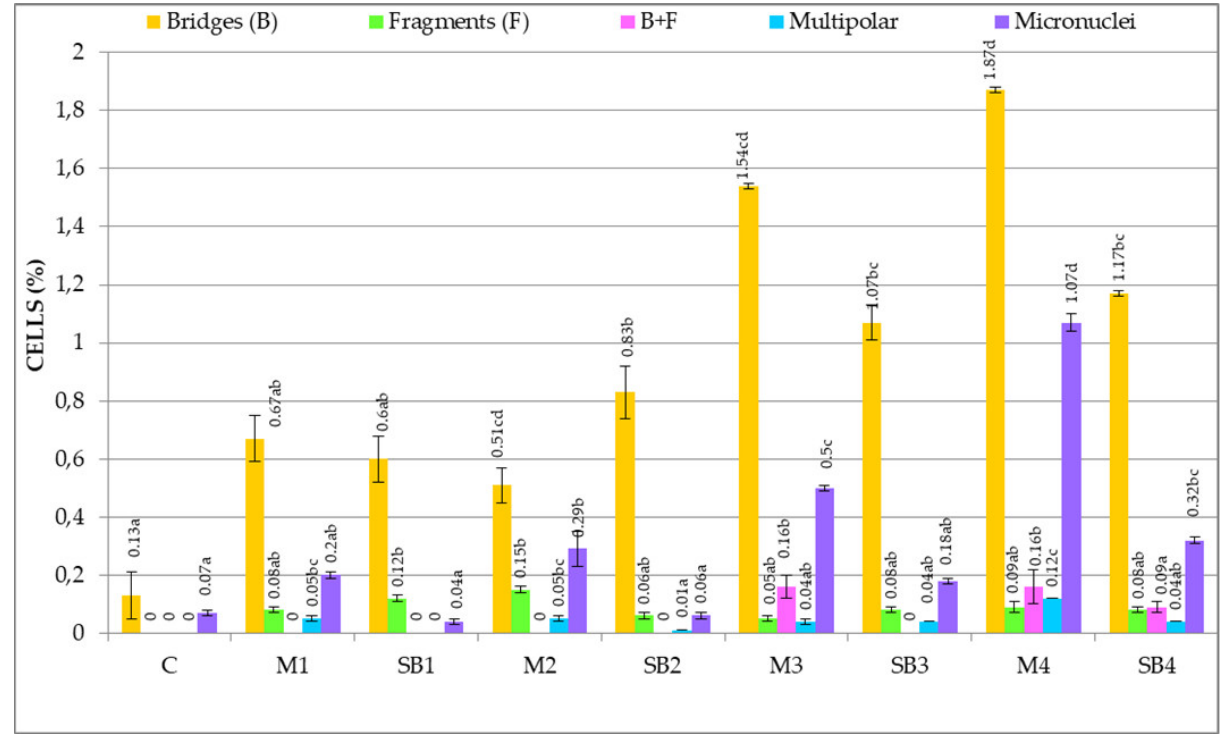
Figure 4. Frequency of genetic abnormalities type in wheat root meristematic cells induced by Merlot and Sauvignon blanc grape marc extracts.